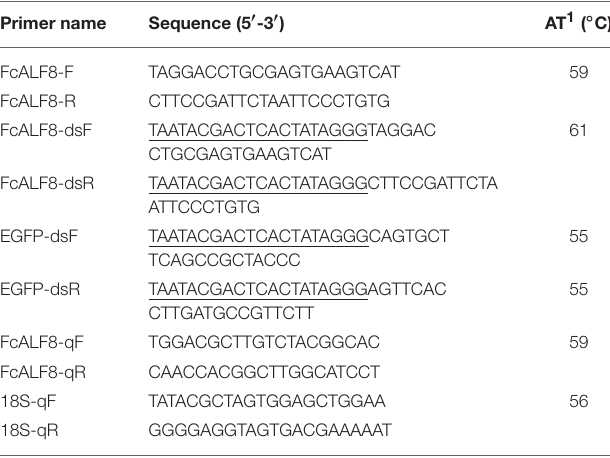
TABLE 1 | Nucleotide sequences of primers used in the present study.